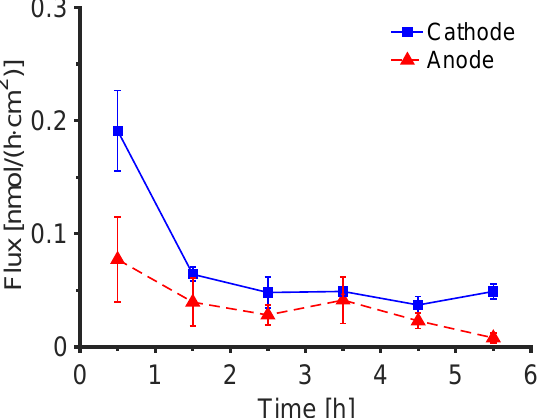
Figure 3. Flux of endogenous Trp extracted by reverse iontophoresis into electrode receiver solutions at pH 7.4. The data are presented as mean ± SEM ( n = 6). Corresponding cumulative amount is shown in Figure S9 in Supplementary Materials.